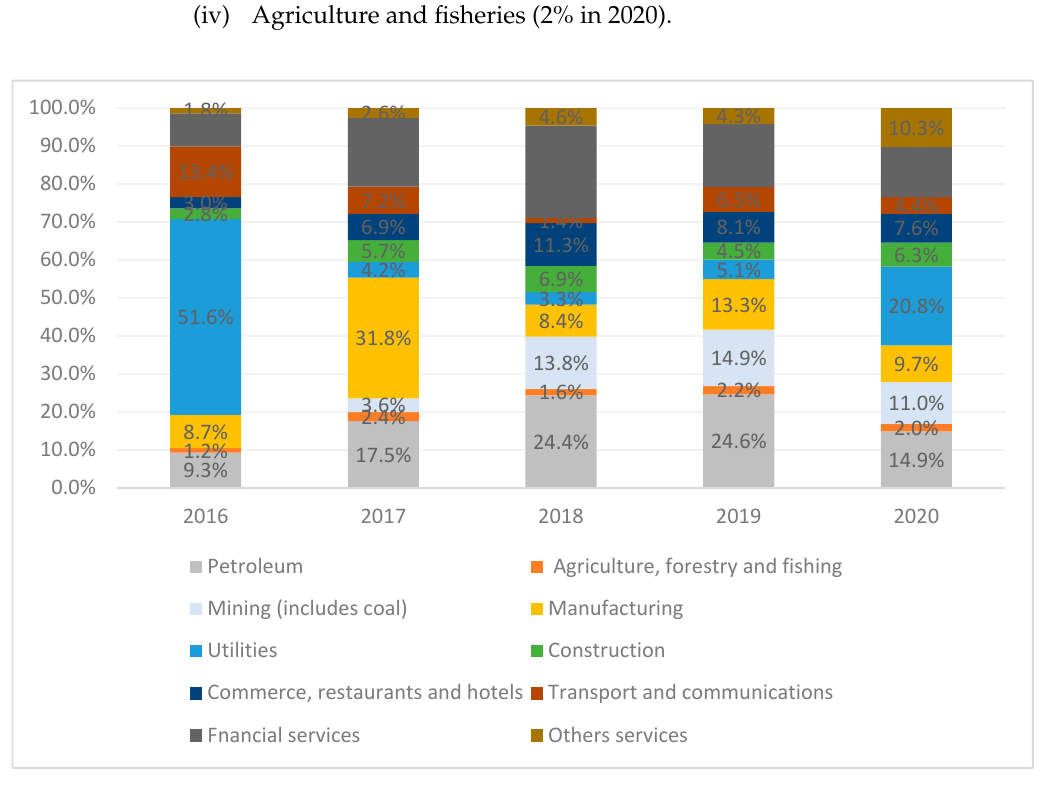
Figure 3. Index of logistics performance (from 1 = Low to 5 = High). Source: Logistics Performance Index, World